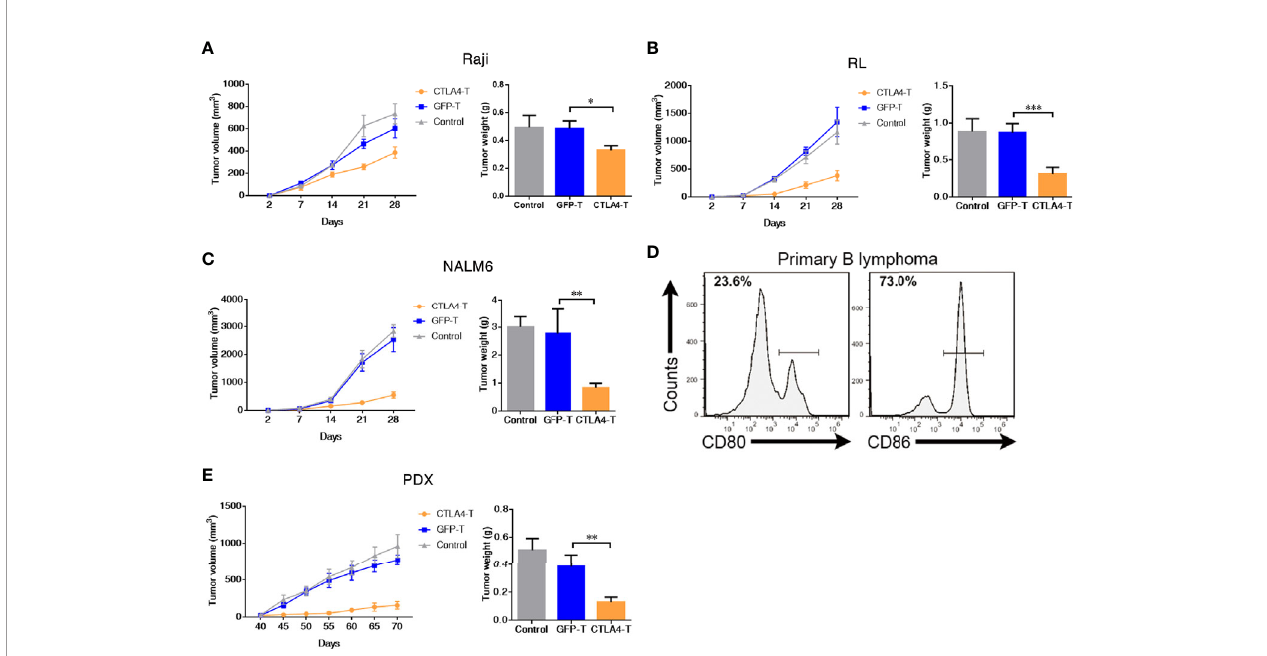
FIGURE 2 | CAR T cells redirected to CD80/86 signi fi cantly suppress the tumorigenesis of subcutaneous xenografts. (A – C) NOD/SCID/IL2Rg − / − mice were subcutaneously injected with 2 × 10 5 of Raji, RL, or NALM6 cells and were intravenously administered human T cells transduced with either chimeric CTLA4 or GFP. Blank control groups comprised mice intravenously administered non-transduced T cells (2 × 10 5 cells, fi ve mice/group). The tumor weight of the Raji, RL, and NALM6 xenografts was weighed after 28 days. The tumor volumes in the CDX models were measured and calculated every 7 days. (D) Representative fl ow cytometric analyses of CD80 and CD86 expression in a xenograft comprising tumor cells from a B cell lymphoma patient. (E) NOD/SCID/IL2Rg − / − mice were subcutaneously transplanted with patient-derived xenografts (PDXs) of B cell lymphoma to create PDX mouse models, which were treated with CTLA4-T, GFP-T, or non-transduced T cells when the tumor volume reached 50 to 100 mm 3 . The total number of GFP-positive T cells injected per mouse was 2 × 10 5 . Tumors in the mice in all three groups ( fi ve mice/group) were weighed at the end of the experiment. The tumor volume was measured and calculated every 5 days. Data are shown as the mean ± SD from independent experiments. One-way ANOVA; signi fi cance values: *P < 0.05; **P < 0.01; ***P <